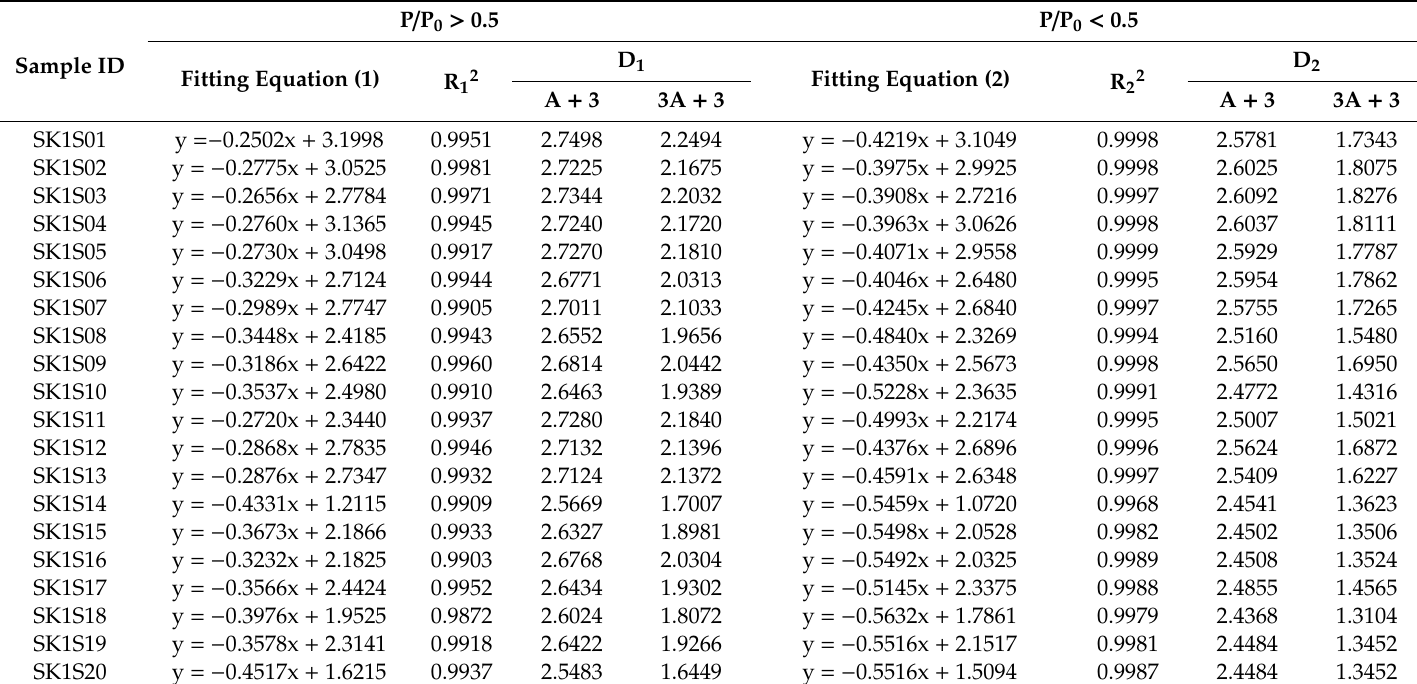
Table A2. Fractal fitting parameters and fractal dimensions calculated using the FHH